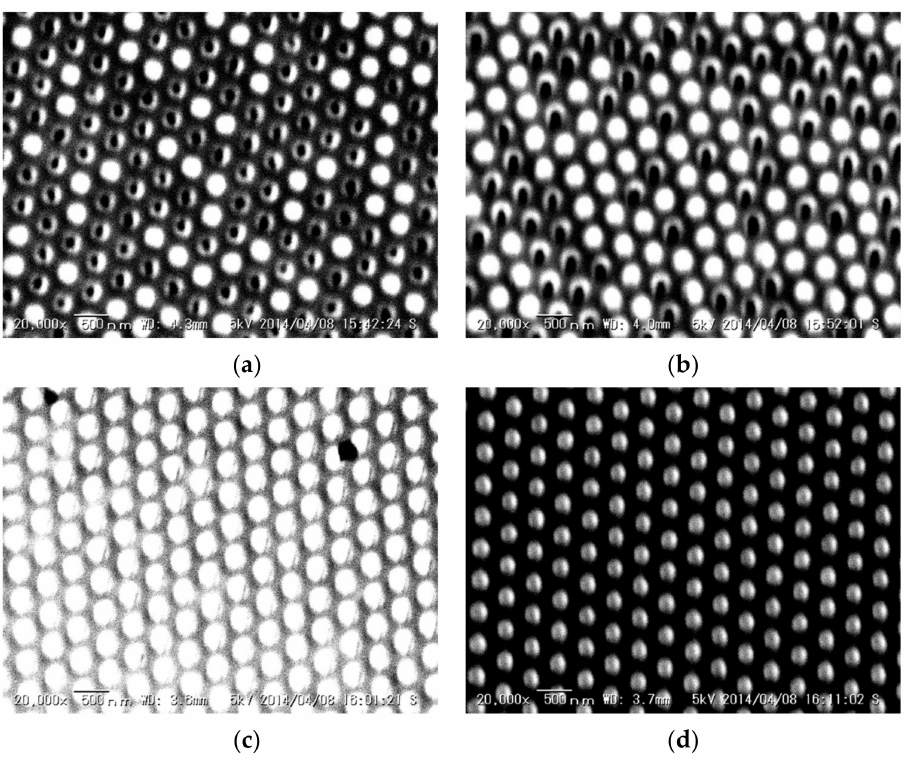
Figure 4. SEM images of PCs fabricated using di ff erent thicknesses of the gold layer. ( a ) 50 nm.